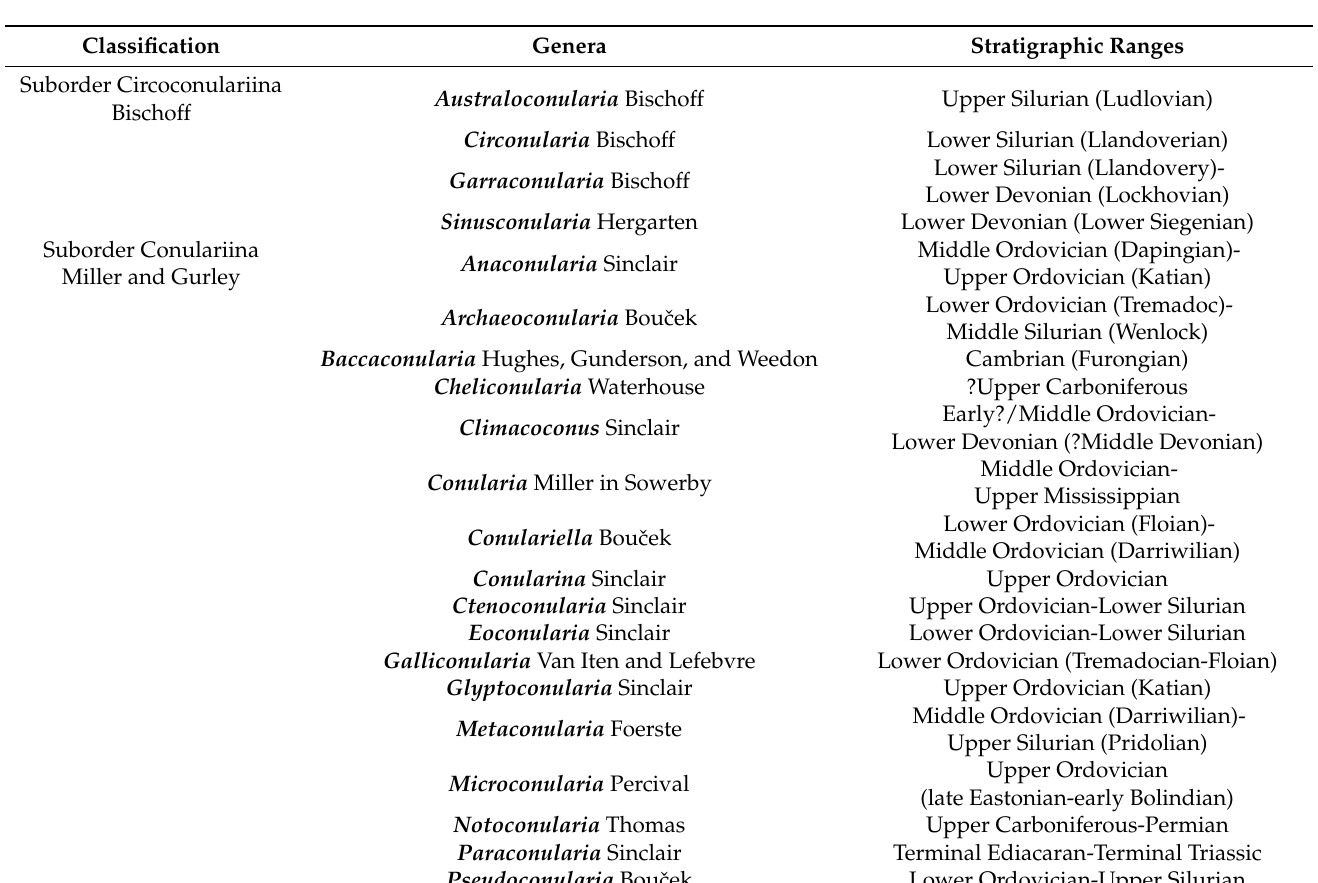
Table 1. The classification of fossil Scyphozoa. Genera with phosphatic skeletons indicated with bold